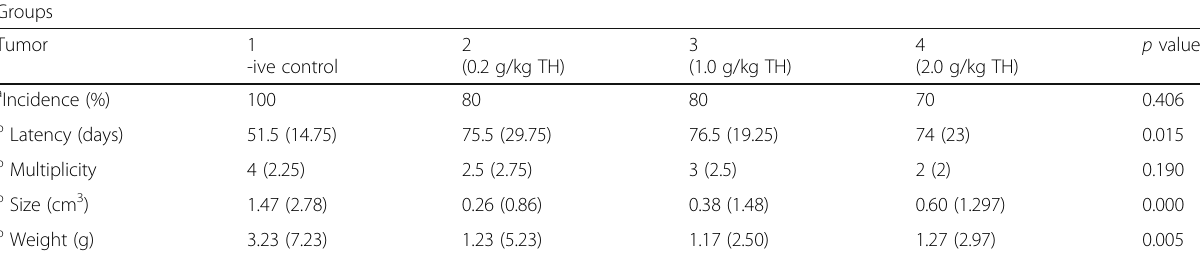
Table 1 The tumor parameters in TH treated groups compared with untreated tumor bearing negative control